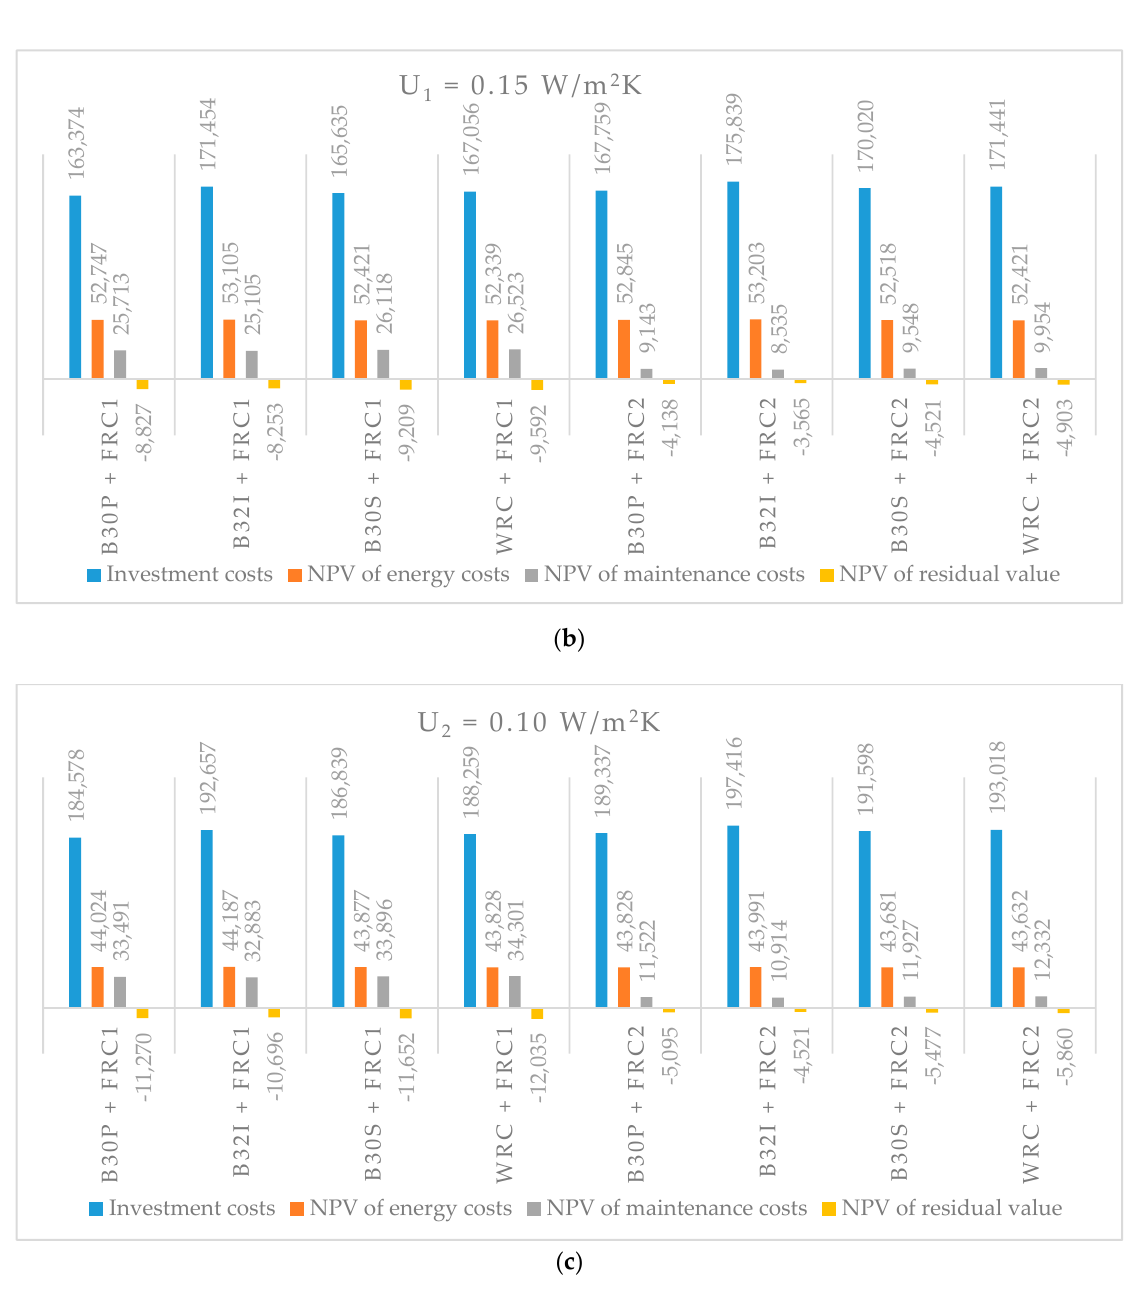
Figure 7. Results of a cost analysis broken down by elements of LCC for all variants: ( a ) at U 0 ; ( b ) at U 1 ; ( c ) at U 2 .